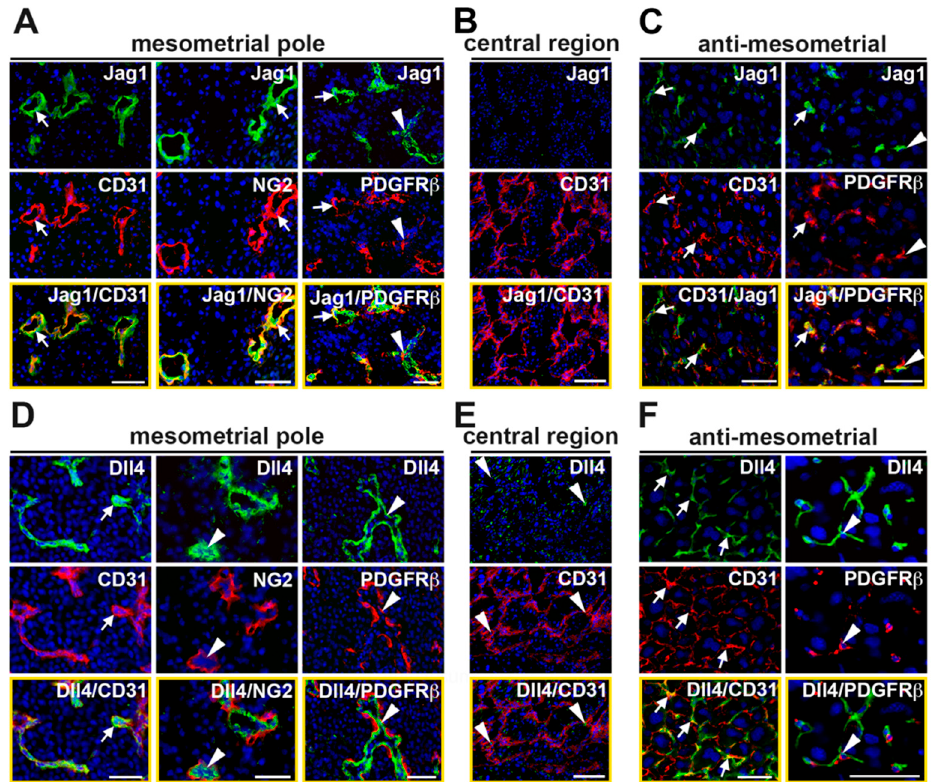
Figure 3. Expression of Notch ligands, Jag1 and Dll4, in the E7.5 decidual vasculature. High magnification images of sections double stained to detect expression of Jag1 or Dll4 and the endothelial cell marker, CD31 or mural cell marker, PDGFR β . ( A ) In MP SpAs, Jag1 is expressed in CD31 + ECs (white arrow) and in NG2 + and PDGFR β + mural cells (white arrows). Some Jag1 + ECs are closely associated with PDGFR β + / Jag1 − mural cells (white arrowheads). ( B ) Expression of Jag1 is not detected in the central region. ( C ) In the AMR, expression of Jag1 is sparse. Jag1 is expressed in CD31 + ECs and PDGFR β + mural cells (white arrows). Jag1 + cells are closely associated with PDGFR β + mural cells (white arrowheads). ( D ) In MP SpAs, Dll4 is expressed in CD31 + ECs (white arrows). NG2 + and PDGFR β + mural cells are closely associated with Dll4 + cells (white arrowheads). ( E ) In the CTR, Dll4 is expressed in a punctate pattern (white arrowheads). ( F ) In the AMR, Dll4 is expressed in CD31 + ECs (white arrows). Dll4 + cells are associated with PDGFR β + mural cells (white arowheads). AMR = anti-mesometrial; CTR = central region; MP = mesometrial pole. Scale bars = 50 µ m.